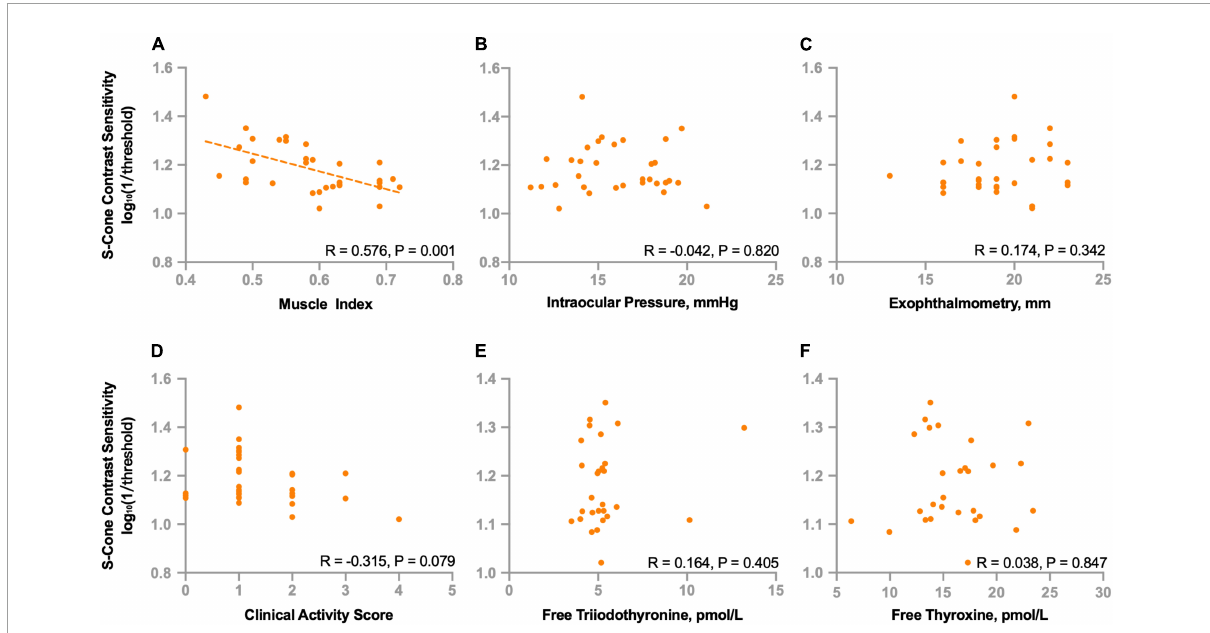
FIGURE5 Correlations between S-cone contrast sensitivity and clinical parameters in non-DON patients. Correlations between S-cone contrast sensitivity and muscle index (A) , intraocular pressure (B) , exophthalmometry (C) , clinical activity score (D) , free triiodothyronine (E) and free thyroxine (F)